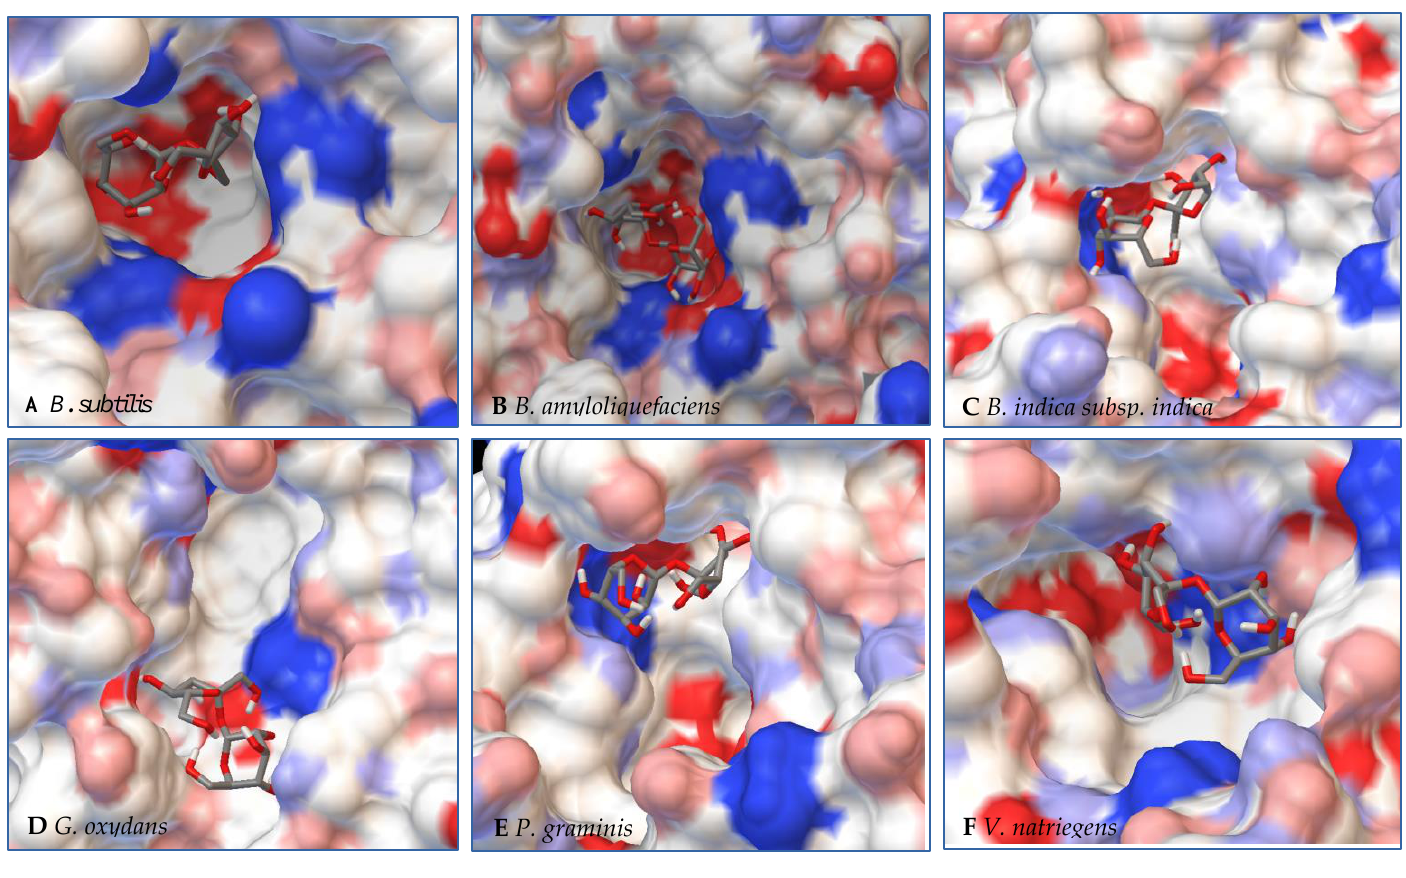
Figure 7. Models of LS from ( A ) B. subtilis, ( B ) B. amyloliquefaciens, ( C ) B. indica subsp. indica, ( D ) G. oxydans, ( E ) P. graminis , and ( F ) V. natriegens with sucrose docked within the active site. Sucrose is docked in a position representing the least binding energy state. Coloring represents the electrostatic surface potential (K b T / e c ) with a spectrum of red (electronegative) to blue (electropositive). The surface charge was calculated using AutoDock v 4.2 and the PDBqt file was uploaded to OPAL webserver for PQR map and visualization was done using PyMol APBS plugin.